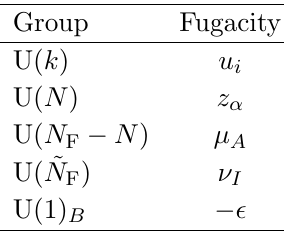
Table 1 . Holonomies and Fugacities of the